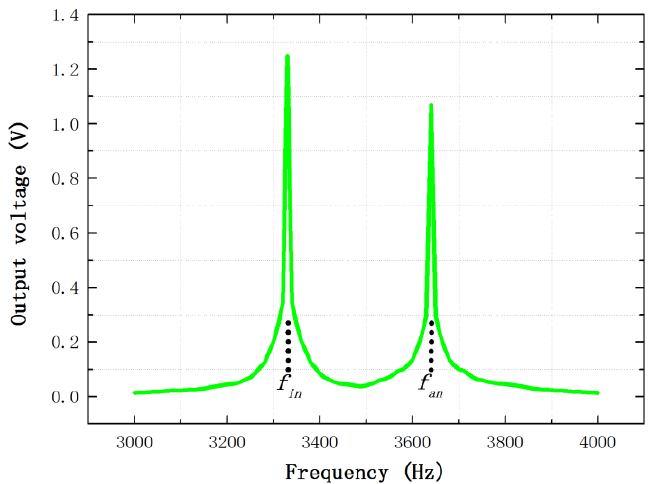
Figure 9. The output voltage of the differential sense capacitance without the stiffness match. Sensors 2016 , 16 , 1146